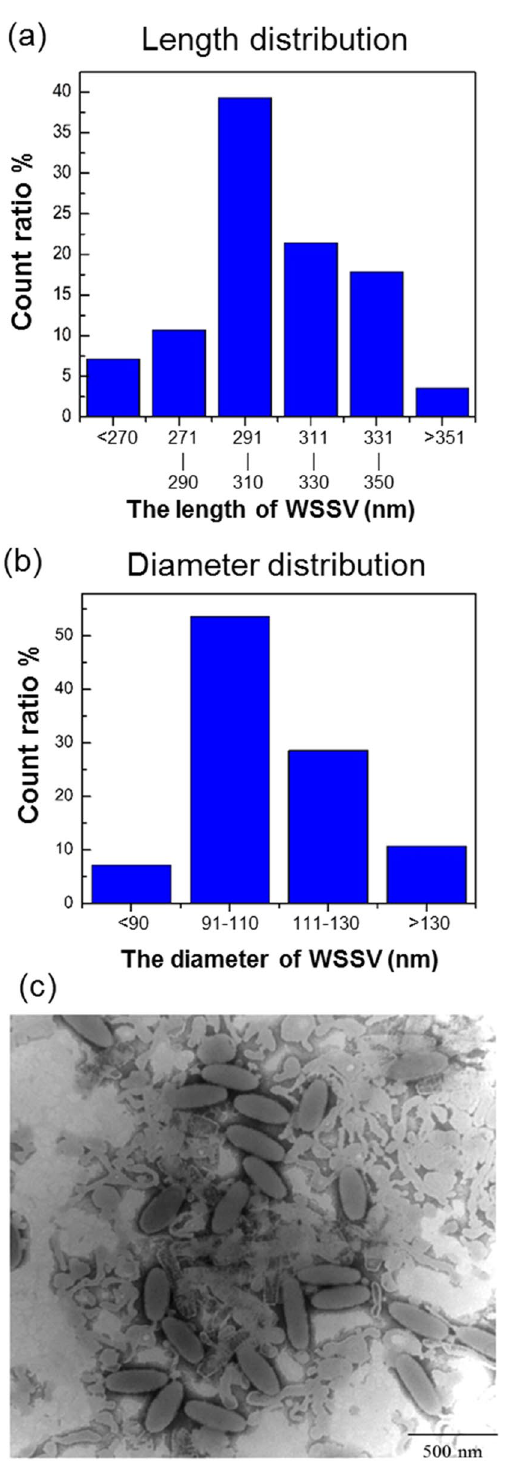
Figure 2. White spot syndrome virus. The ( a ) length and ( b ) diameter distribution of white spot syndrome virus (WSSV) as summarized by its ( c ) transmission electron